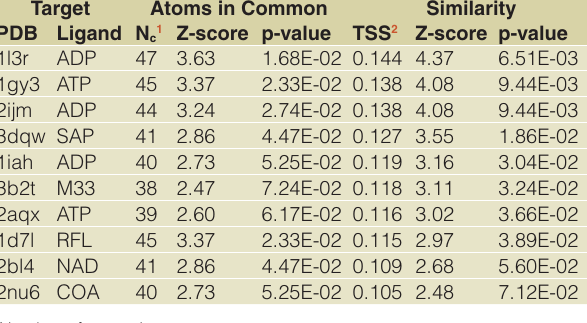
Table 1. IsoCleft Finder results for 3e7e sorted in decreasing order of Tanimoto Score of Similarity. Target Atoms in Common